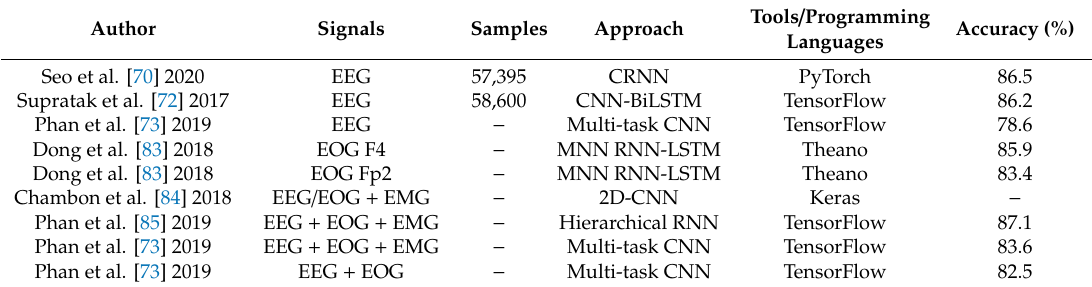
Table 3. Summary of automated sleep stages classification approaches with DL applied to PSG recordings in Montreal Archive of Sleep Studies (MASS) dataset.